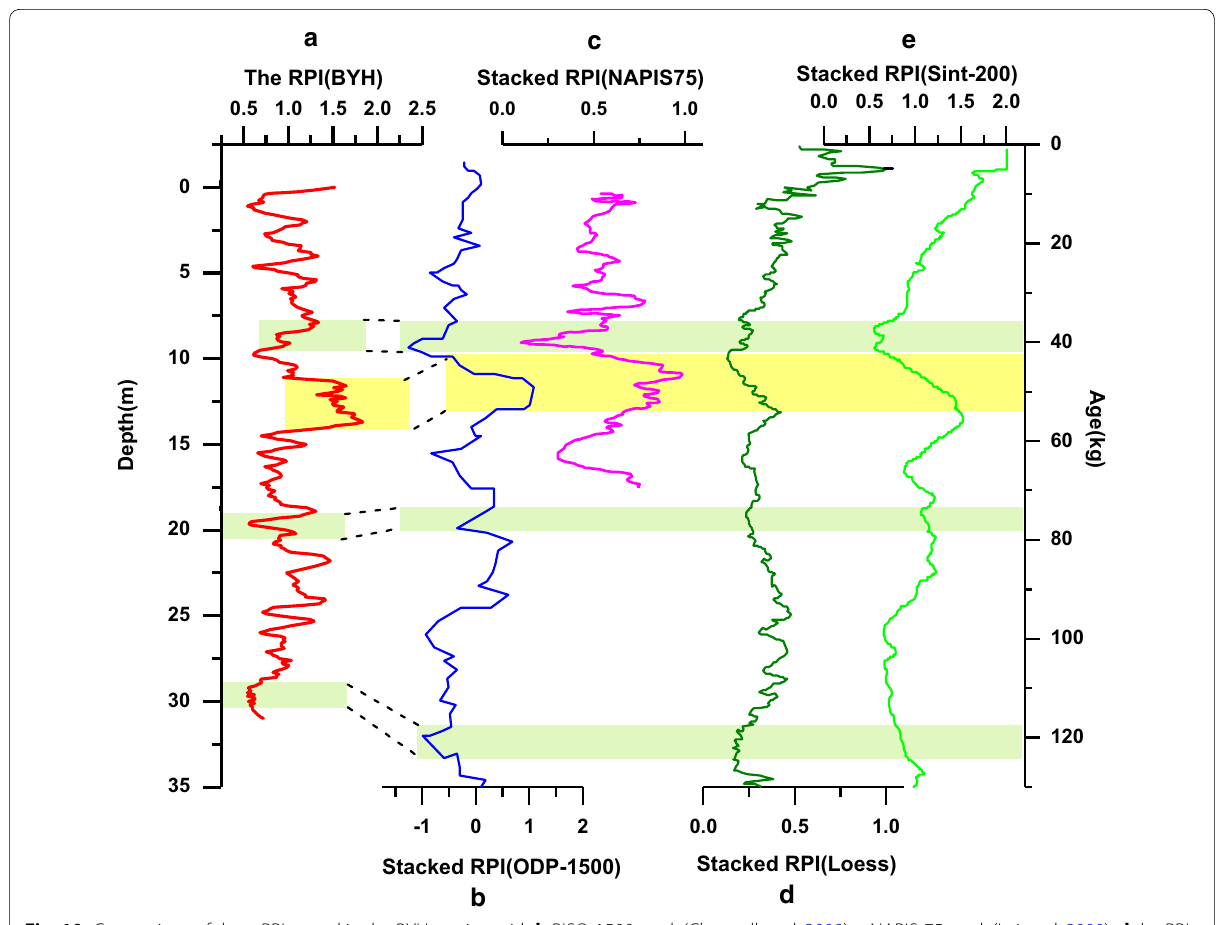
Fig. 10 Comparison of the a RPI record in the BYH section with b PISO-1500 stack (Channell et al. 2009), c NAPIS-75 stack (Laj et al. 2000), d the RPI stacks based on cosmic nuclides in the CLP (Zhou et al. 2010) and e the Sint-200 stack (Guyodo and Valet